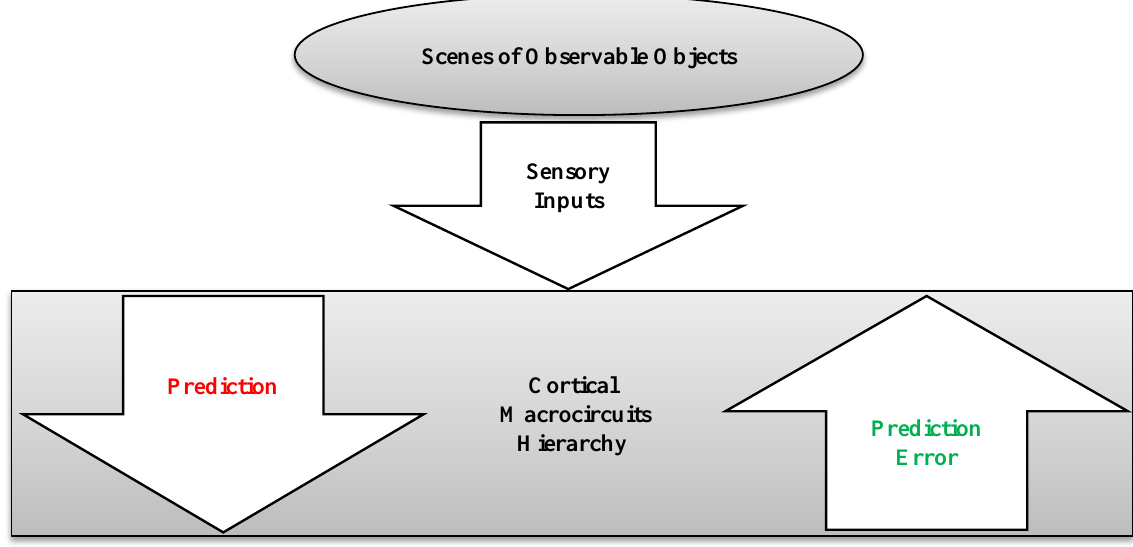
Figure 2. Top-down adjustment of perception by minimizing the prediction error in a two-way real-time pairing